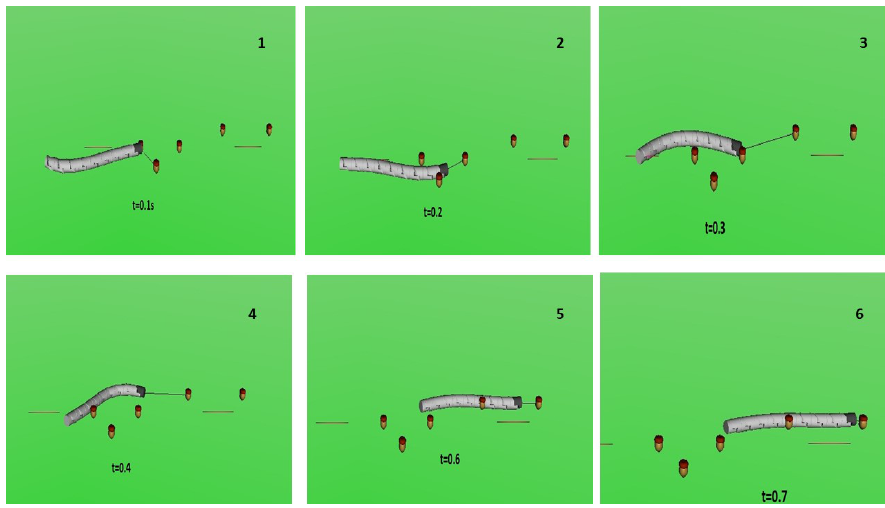
Figure 2. Visualisation of the snake robot implemented in Simulink 3D